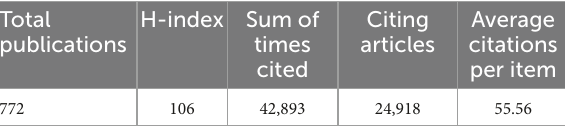
TABLE 1 Bibliographic statistics of 772 recorded publications extracted from